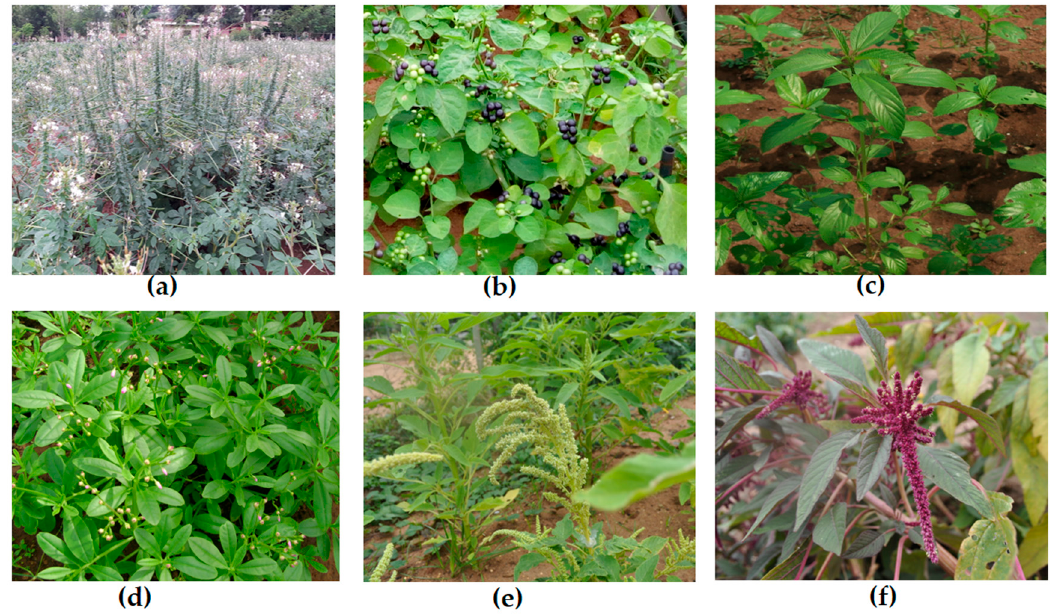
Figure 1. Some of important African traditional leafy vegetables widely used across Africa: ( a ) Gynandropsis gynandra , ( b ) Solanum nigrum , ( c ) Corchorus olitorius , ( d ) Talinum triangulare , ( e , f ) Amaranthus spp. Pictures: courtesy of F.S. Sohindji, H.F.P. Zohoungbogbo and E.G. Achigan-Dako.